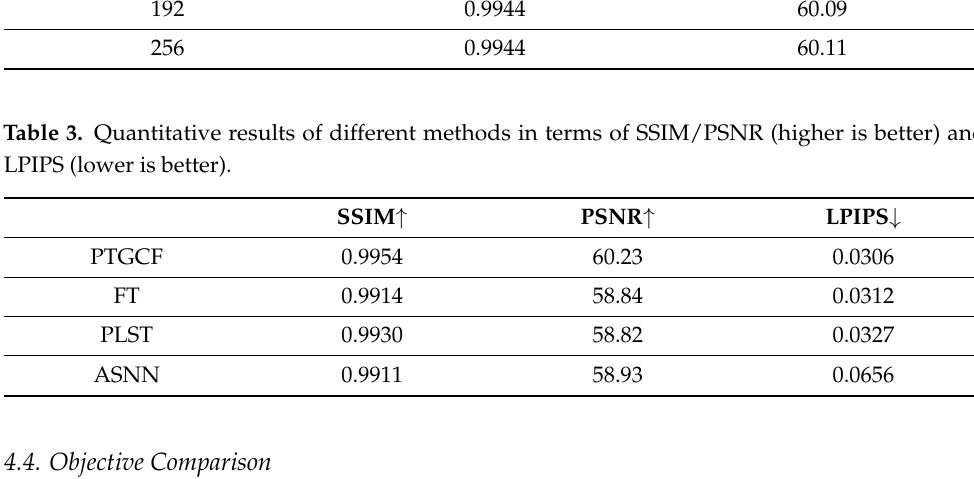
Table 2. Quantitative results of Brush stroke window size comparison in terms of SSIM/PSNR (higher is better).